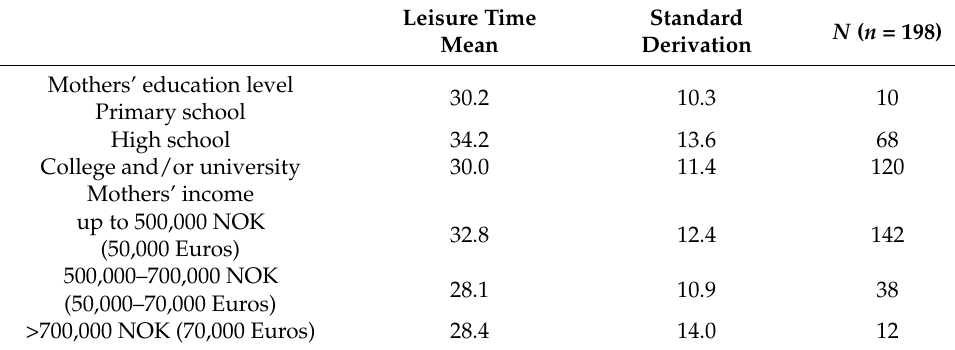
Table 2. Descriptive characteristics of children’s MVPA level at leisure, according to the independent variables: mothers’ education level and annual